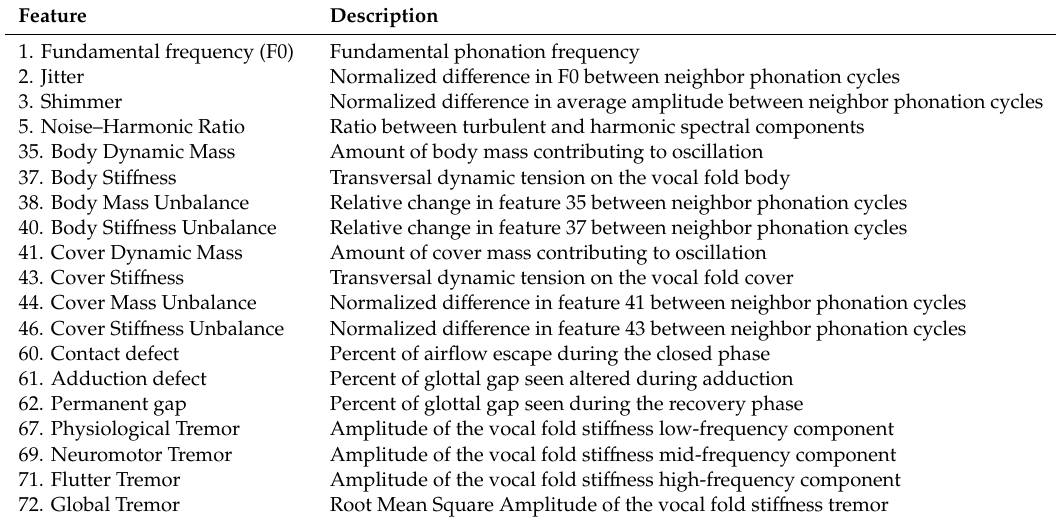
Table 2. List of the 19 acoustic and biomechanical features used in this study.